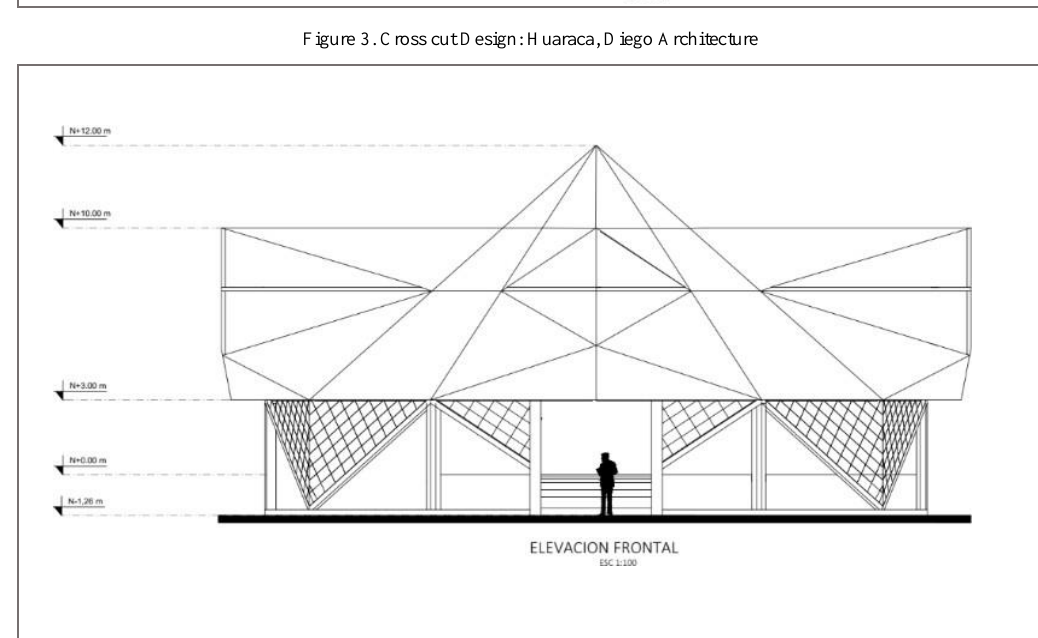
Figure 4. Front view and elevation Design: Huaraca, Diego Architecture Foundations: 4 pambil pillars of 25 to 30 cm in diameter 12 m high Peripheral structure: 14 chonta pillars of 20 cm in diameter, 6 of 10m high and 8 of 3m high. Enclosures: woven bamboo, 8 6x3 panels and 2 3x3 panels Roofing: 38 panels of recycled plywood 1.22x2.44 and 113m2 of woven chonta